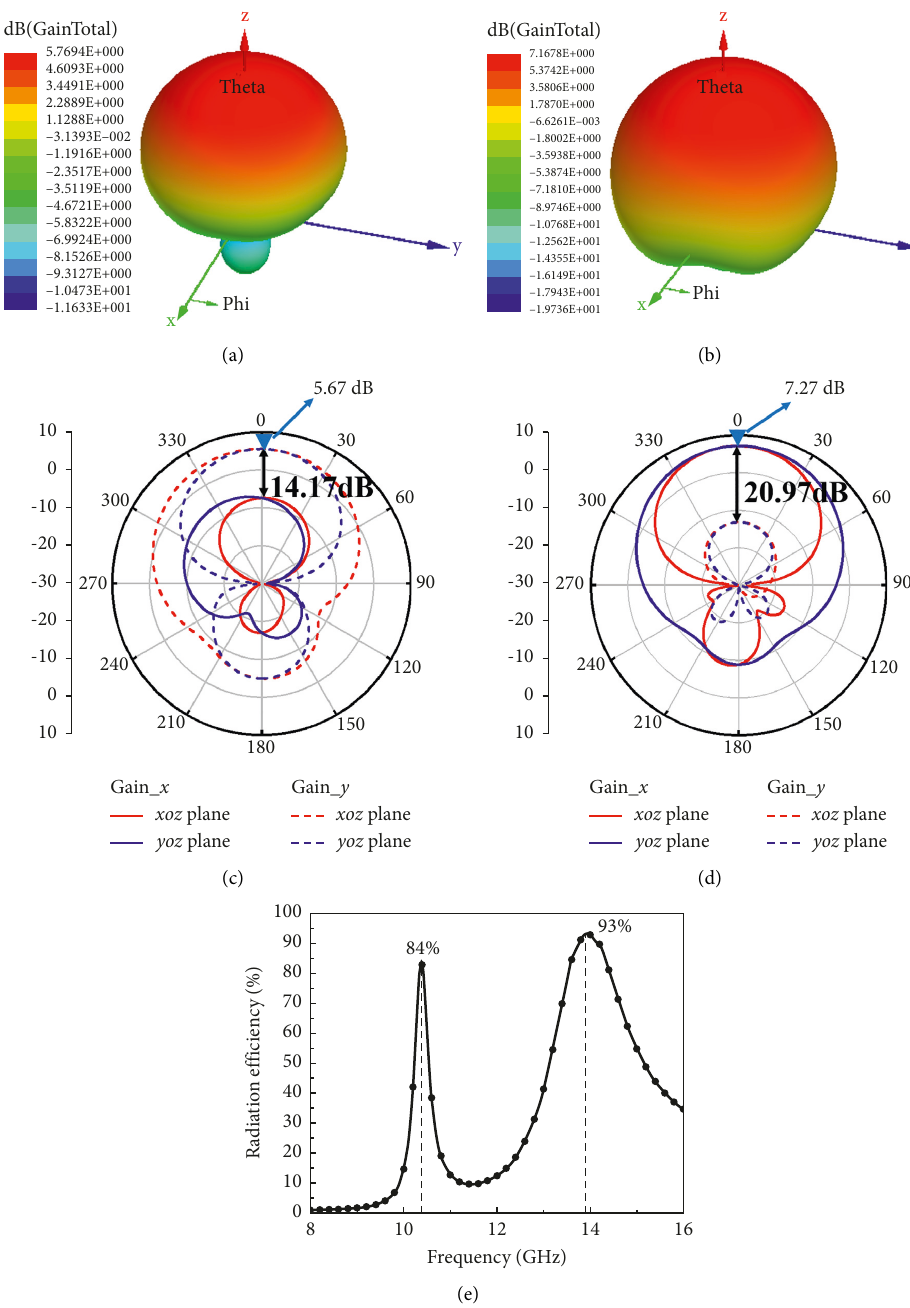
Figure 5: Simulated radiation performance of the proposed antenna. (a) 3D view at 10.38GHz. (b) 3D view at 13.9GHz. (c) Radiation pattern on xoz and yoz plane at 10.38GHz. (d) Radiation pattern on xoz and yoz plane at 13.9GHz. (e) Simulated antenna efficiency of the proposed